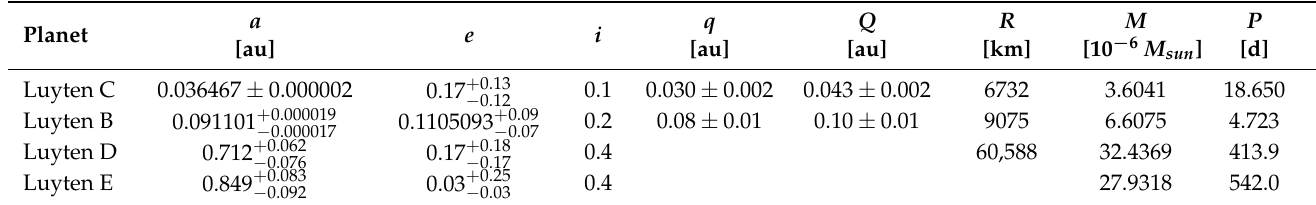
Table 1. Osculating elements of Luyten C and Luyten B [1,4] and mass (in Sun masses) for all planets. The radius was computed assuming the density equivalent to that of the Earth’s ( ρ = 5514 kg/m 3 ) for the inner planets and to that of Saturn’s ( ρ = 687 kg/m 3 ) and a spherical shape. The errors for perihelion q and aphelion Q are the standard deviation from the eccentricity and semi-major axis